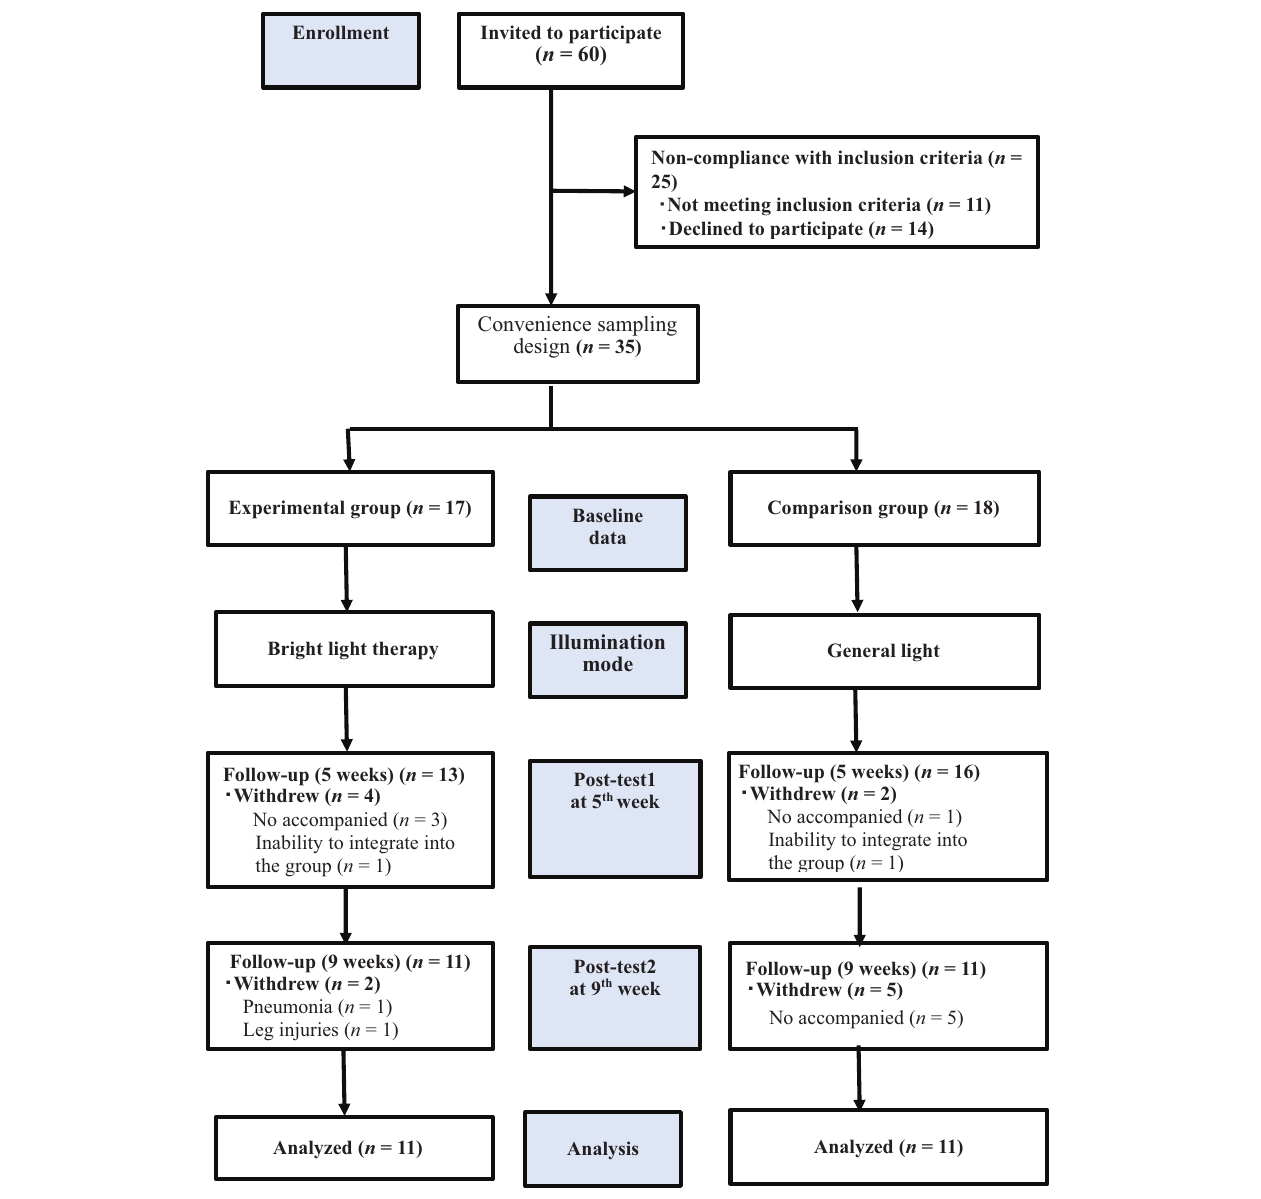
FIGURE 1 | The flow chart of the study. We included 35 patients who underwent the baseline evaluation and postintervention assessments in the 5th and 9th weeks. allocated them to the experimental ( n = 17) and comparison ( n = 18) groups; only 22 patients completed the study, and the experimental and comparison groups were exposed to bright light therapy (2,500 lux) and general lighting,